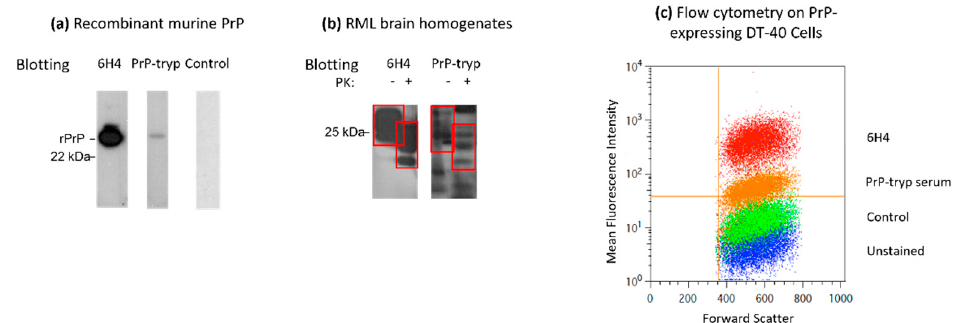
Figure 3. Characterization of the immune sera. Immune serum was used as the primary antibody in Western blots to detect recombinant murine PrP ( a ) or PrP in brain homogenates from terminally ill Rocky Mountains Laboratory (RML) mice ( b ). The immune serum recognizes recombinant PrP, as well as total PrP (PrP C and PrP Sc ) and PrP Sc in brain homogenates. ( c ) The immune serum also recognized PrP expressed on the surface of DT-40 cells stably transfected to express PrP. PrP-tryp: serum from a mouse immunized with PrP-VSG expressing trypanosomes; Control: serum from a mouse immunized with WT-VSG expressing trypanosomes; 6H4: monoclonal anti-PrP antibody. Red boxes indicate the di-, mono- and unglycosylated forms of PrP. Data from a representative PrP-tryp and a control serum (second bleed) are depicted in all three